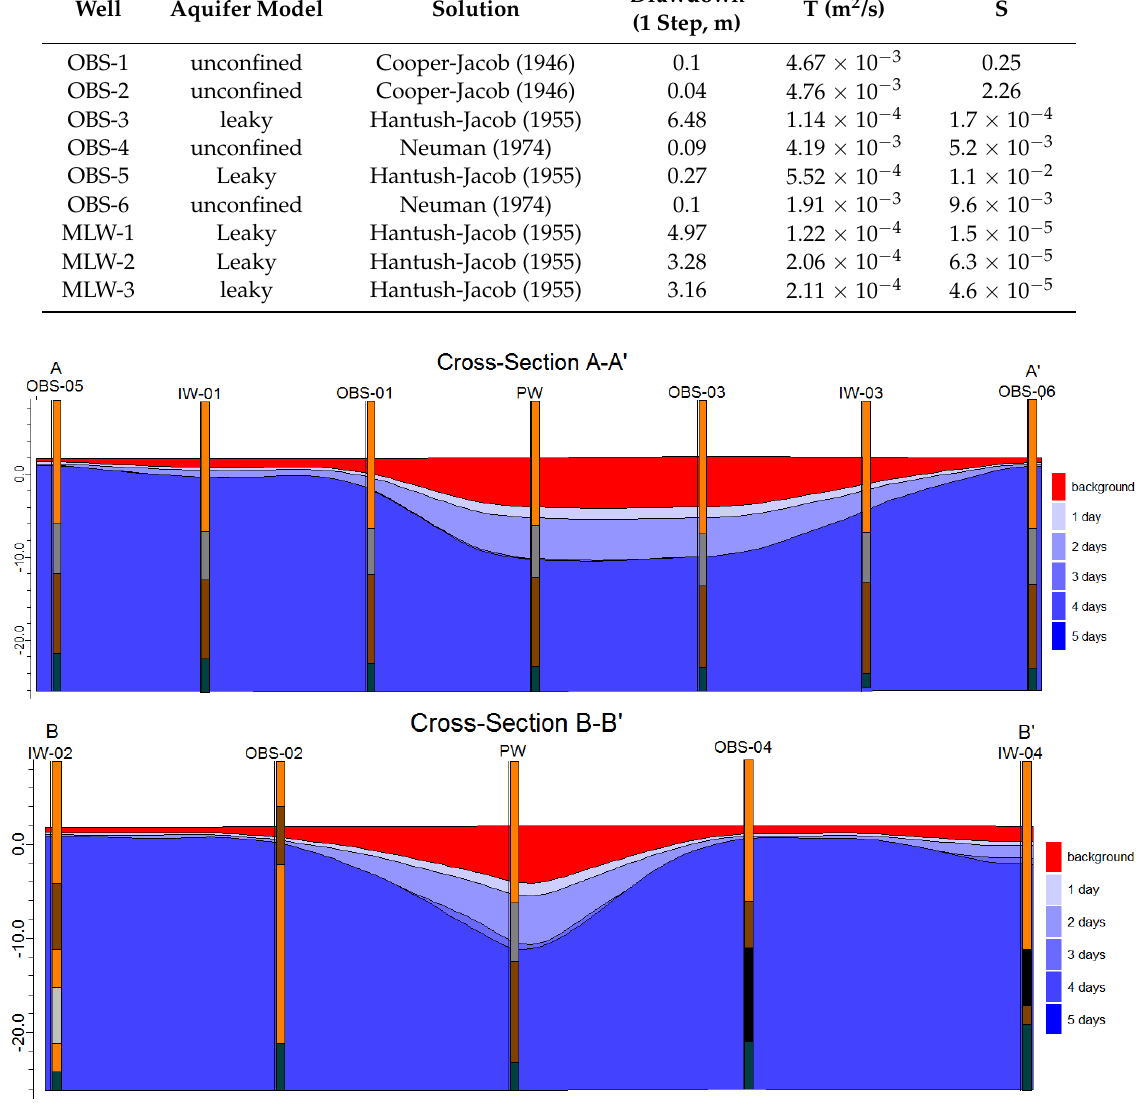
Figure 5. Cross-sections A-A’ and B-B’ showing drawdown in the pumping and observation wells during pumping